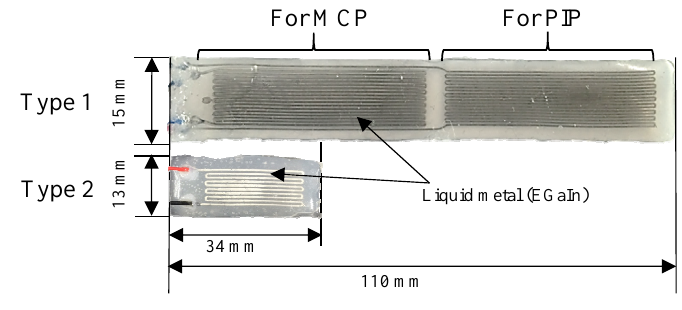
Figure 4. Prototypes of the soft